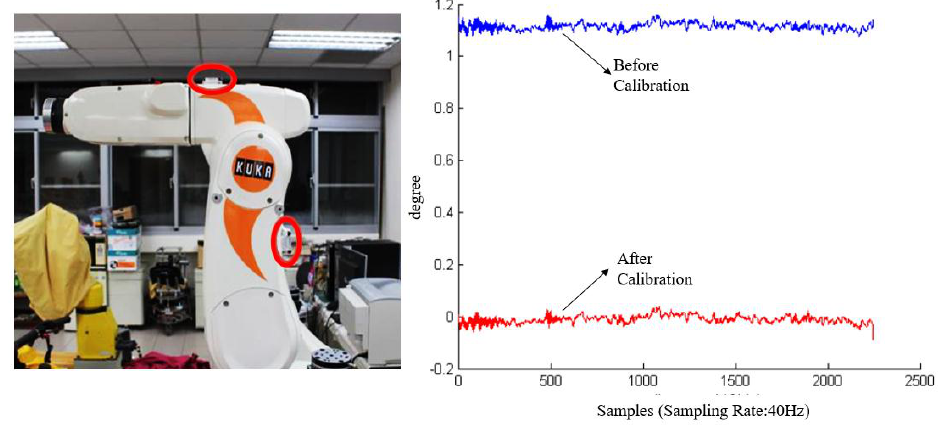
Figure 4. The robotic arm for sensor calibration.